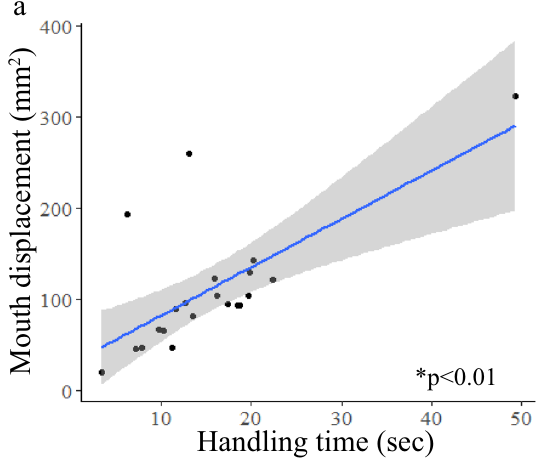
Figure 6. Linear regression of multiple copepod encounter data showing a significant relationship between handling time and total mouth displacement ( p < 0.01, r 2 = 0.47). Grey shaded region shows 95% confidence interval. Statistical calculations were performed using a log transformation. Data in figure are shown without